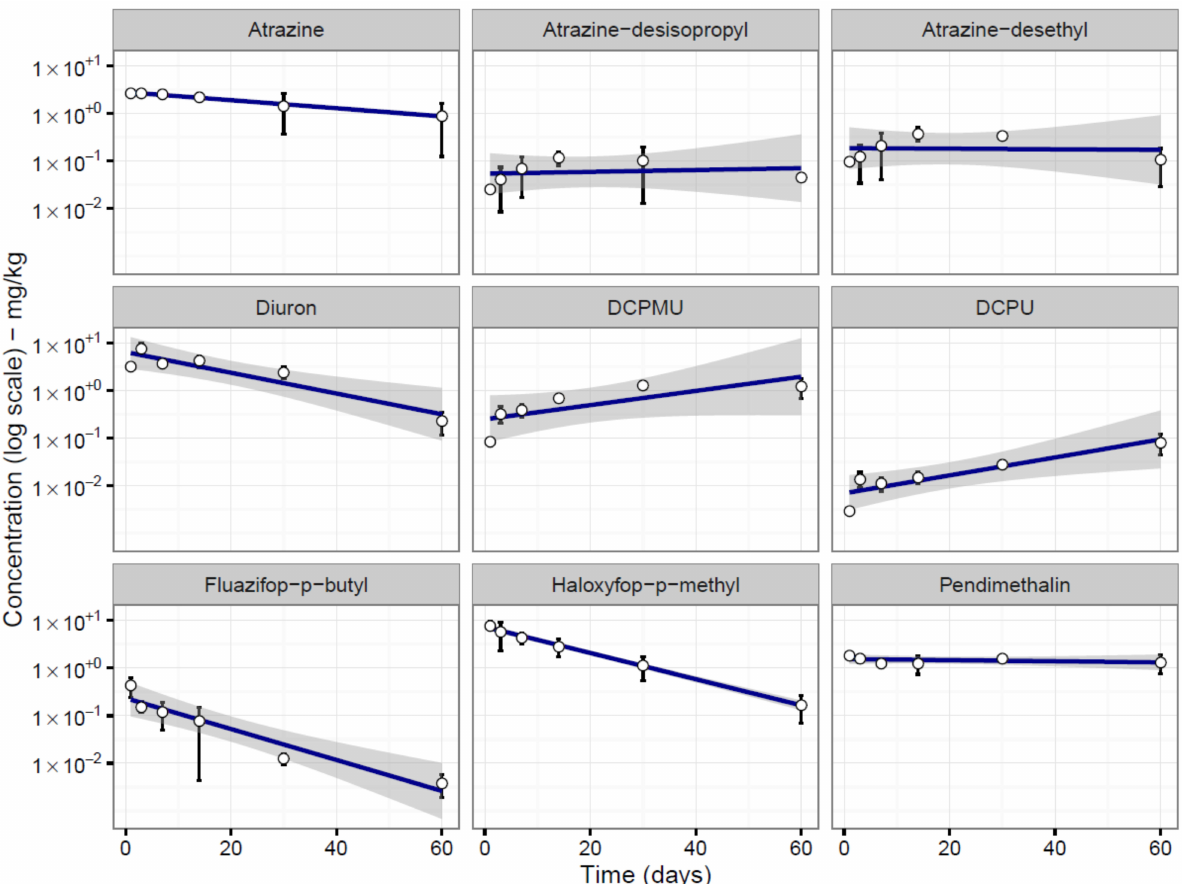
Figure 1. LC–MS analysis of soil samples spiked with five herbicides ( n = 4). DCPMU: 3–(3,4– dichlorophenyl)–1–methylurea and DCPU: